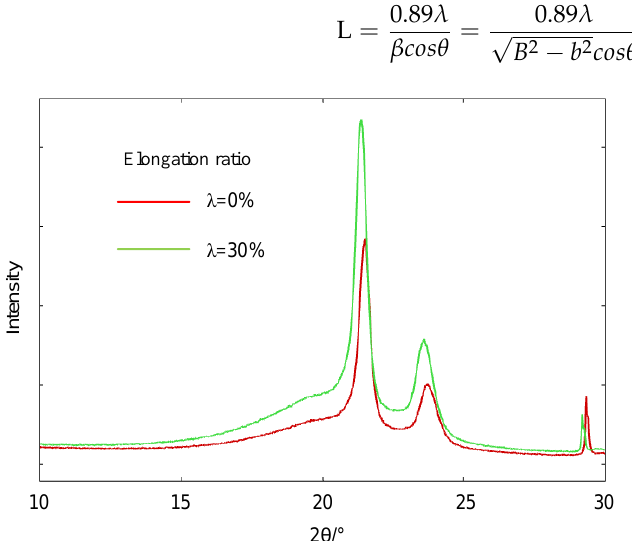
Figure 5. XRD patterns of polyethylene with different elongation ratios.